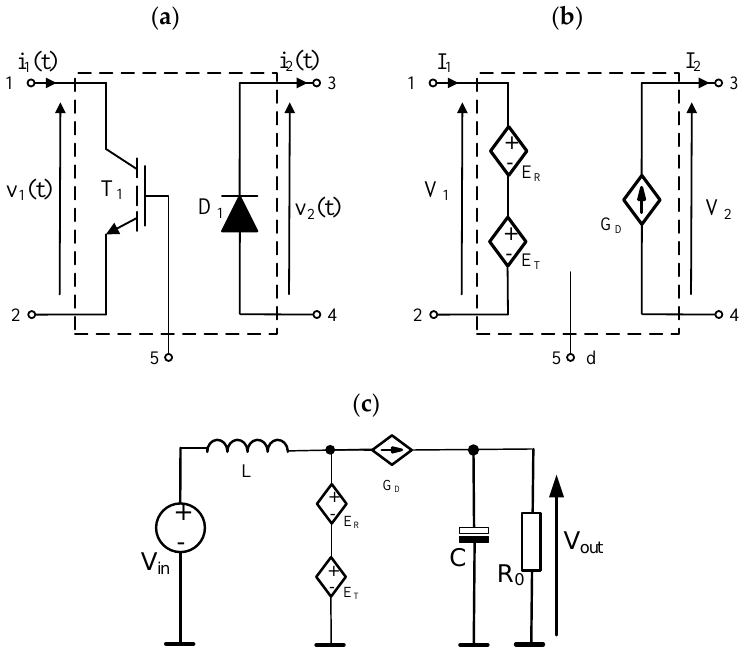
Figure 2. PWM switch with the IGBT ( a ), the equivalent model of this switch ( b ), the averaged model of the DC–DC boost converter containing a model of this switch ( c ).